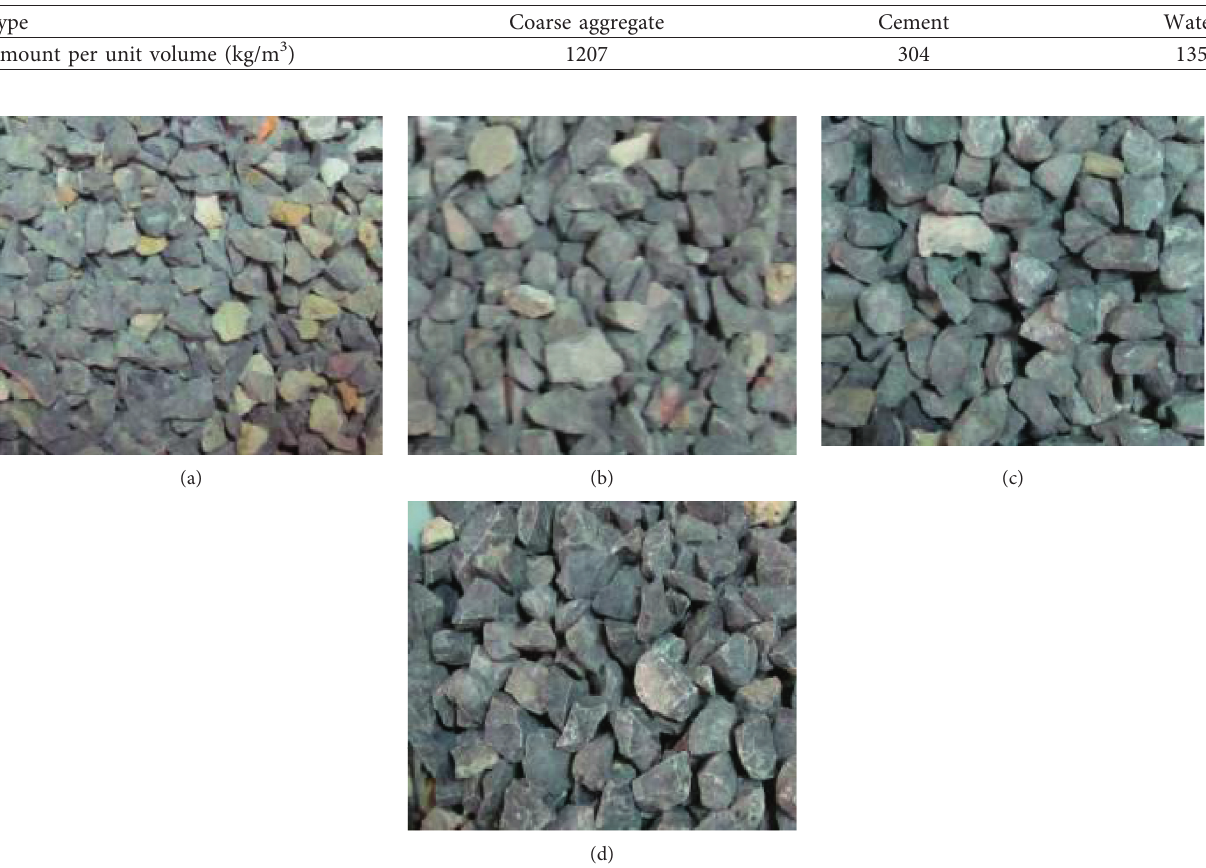
Table 1: Designed mix ratio of green porous sponge ecological concrete.